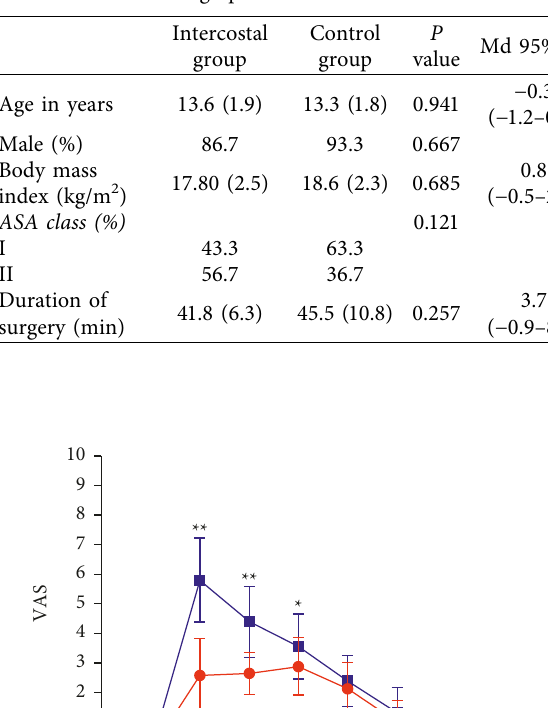
Table 2: Demographic and baseline characteristics.